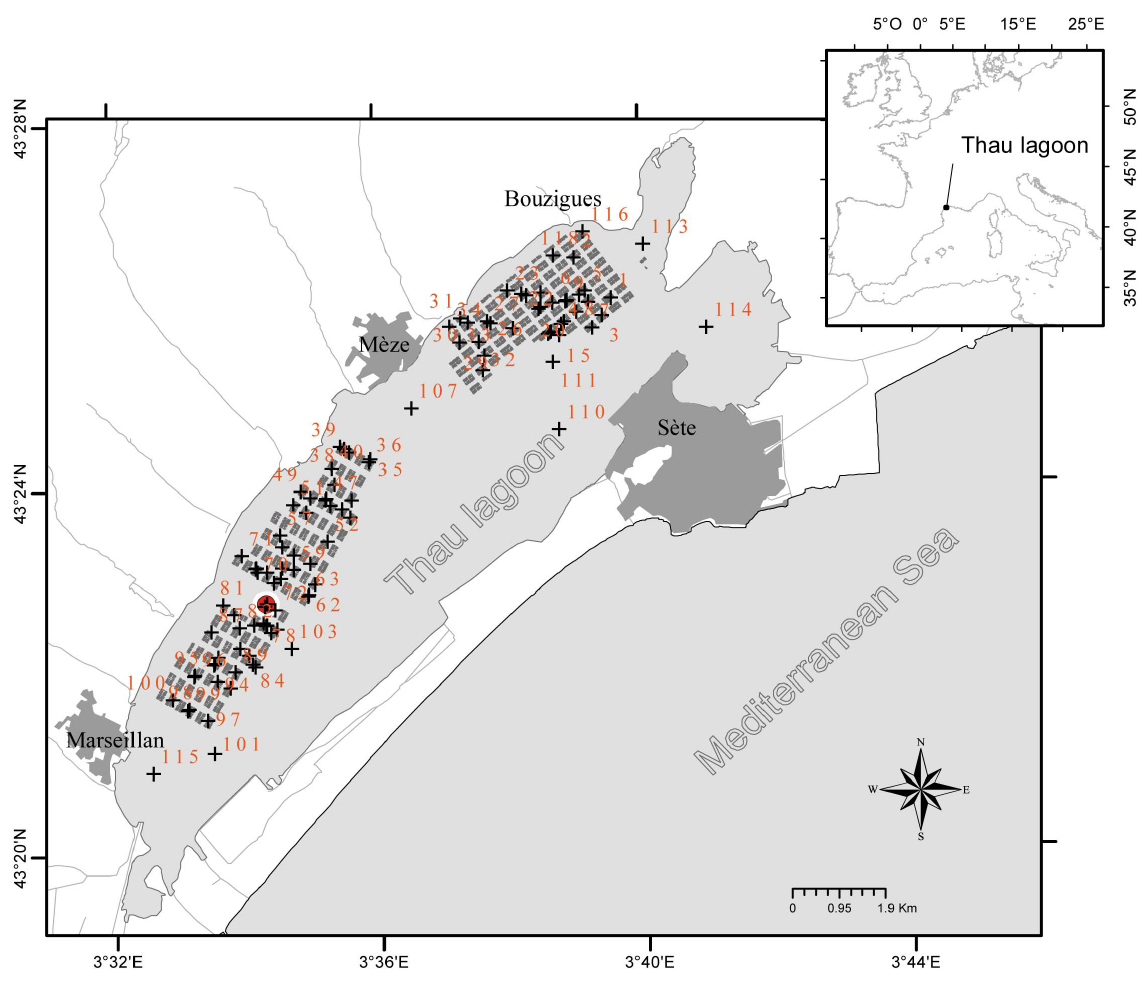
Figure 1. Sampling sites (black crosses along with non-continuous numbering) located in the Thau lagoon. Areas with grey boxes: bivalve farms; red circle: temperature probe.